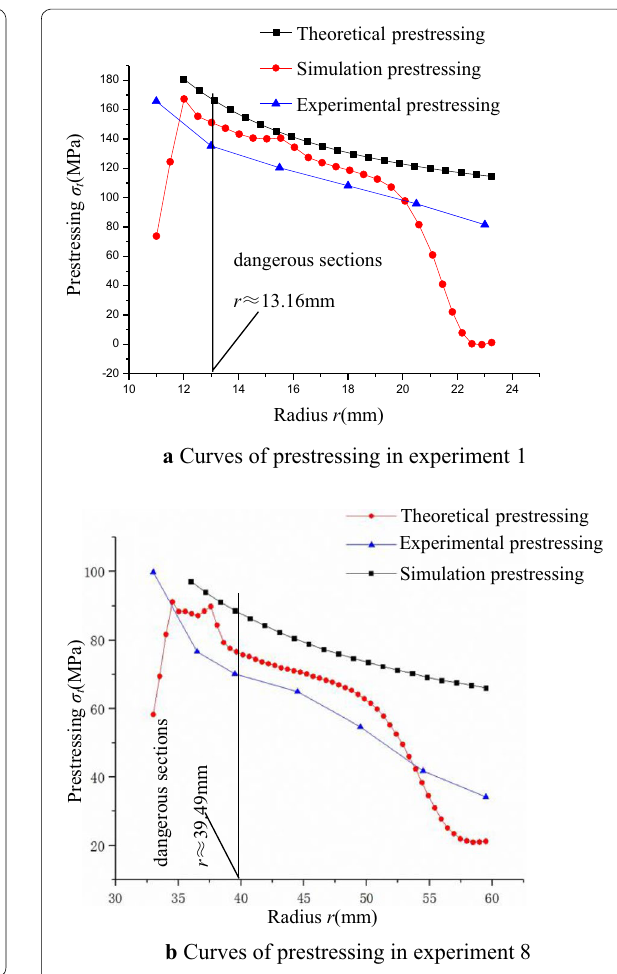
Figure 7 Curves of